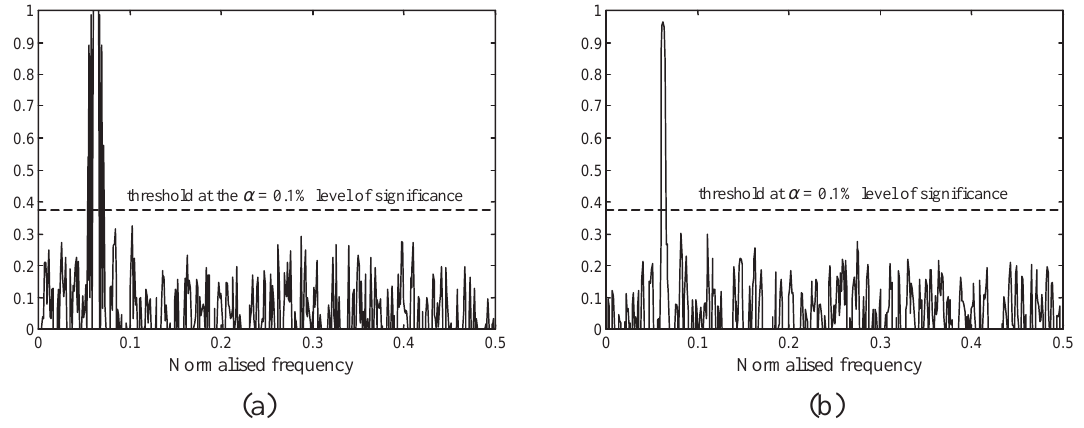
Fig. 7. Estimated indicator I ( f ) on the signal of Fig. 1. (a) Signal-to-noise ratio = ∞ . (b) Signal-to-noise ratio = 0 dB. The two resonances are correctly recognised as not being tones. Note the high level of estimation noise. The proposed indicator can easily be estimated from a single data record, for instance by using the Welch’s